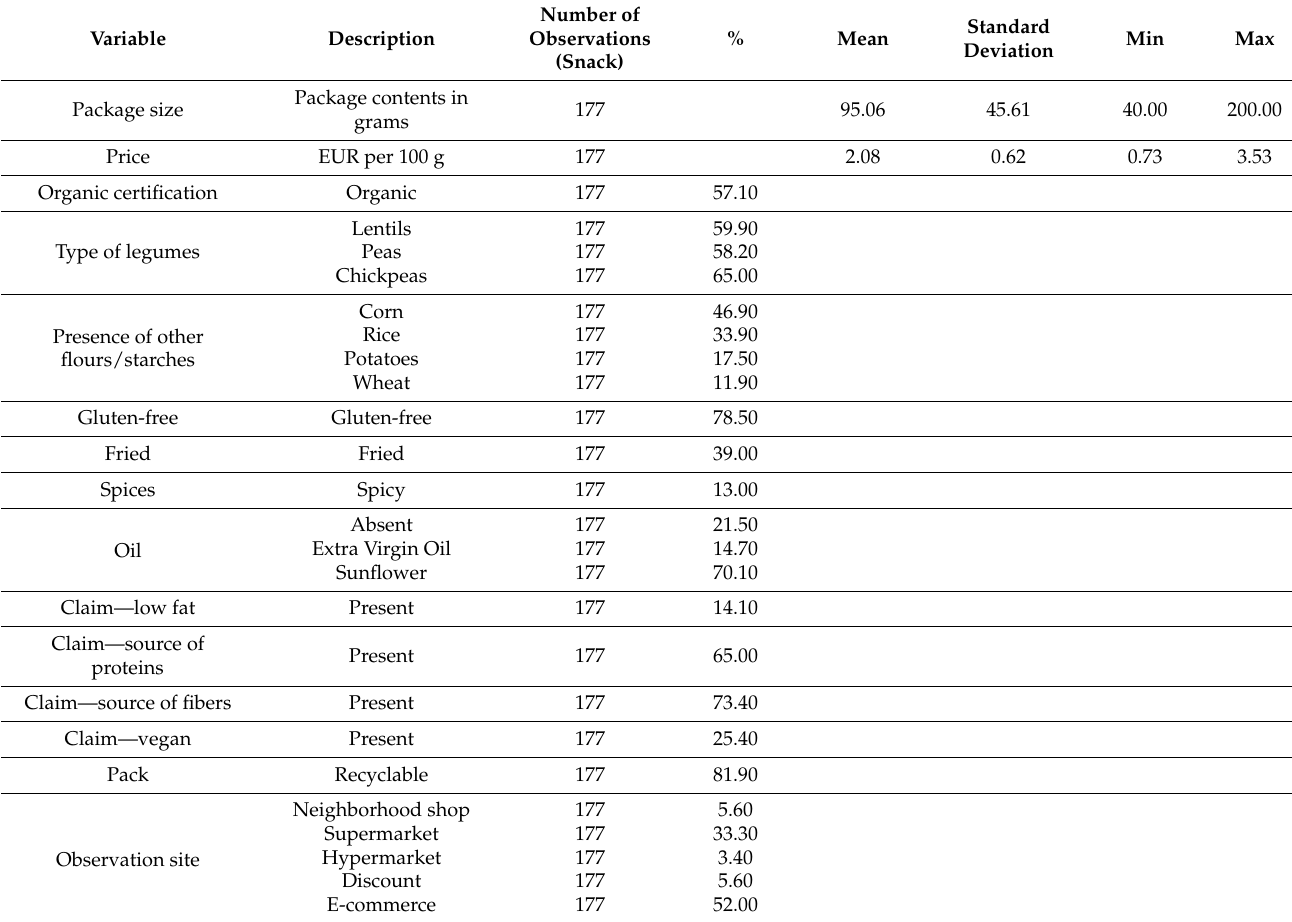
Table 7. Descriptive statistics of snacks used in our hedonic price model analysis.